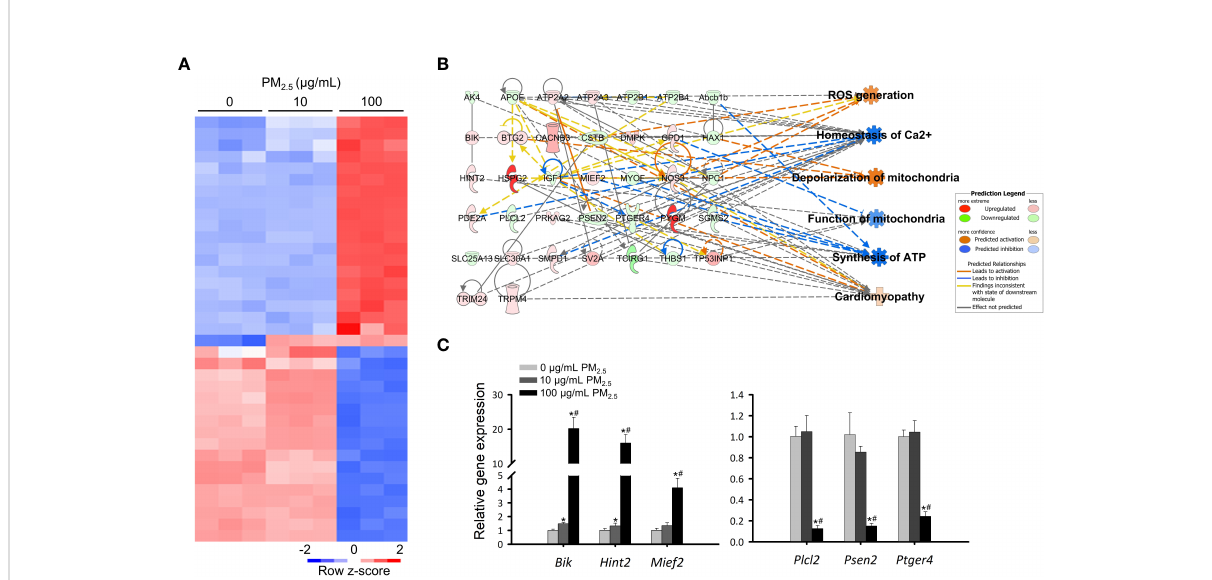
FIGURE 2 Transcriptomics analysis of PM 2.5 -treated HL-1 cells. (A) Heatmap of differentially expressed genes in 0, 10, and 100 m g/mL PM 2.5 -treated cells. Gene expression levels were analyzed three times per condition. (B) Transcriptome network with an in silico prediction of PM 2.5 -treated cells. A network of cellular functions and disease-related genes was generated using IPA (https://www.ingenuity.com). Green and red indicate downregulated and upregulated genes, respectively. Dotted and solid lines indicate indirect and direct relationships, respectively. Details for shape are provided in Supplementary Figure 1. (C) qPCR analysis for Bik , Hint2 , Mief2 , Plcl2 , Psen2 , and Ptger4 in 0, 10, and 100 m g/mL PM 2.5 - treated cells. Gapdh was used as a reference gene. Data represent independently performed triplicate experiments. * p -value < 0.05 vs. control; # p -value < 0.05 vs. 10 m g/mL PM 2.5 -treated